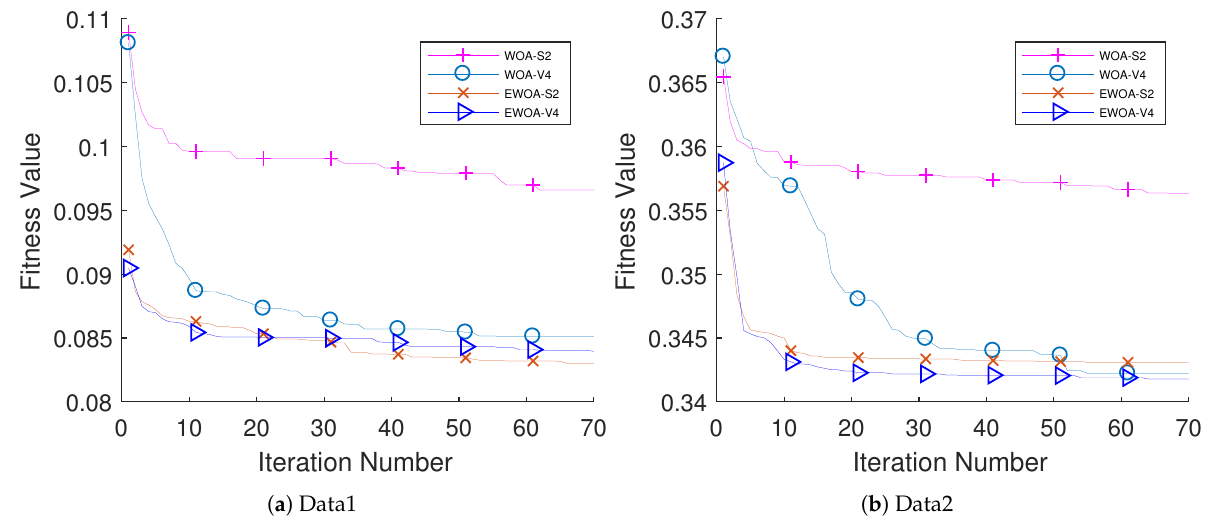
Figure 15. The convergence for the EWOA and WOA using S2 and V4 TFS. Table 14. The selected features by EWOA-V4 for Data1 over 10 independent runs. Selected Features